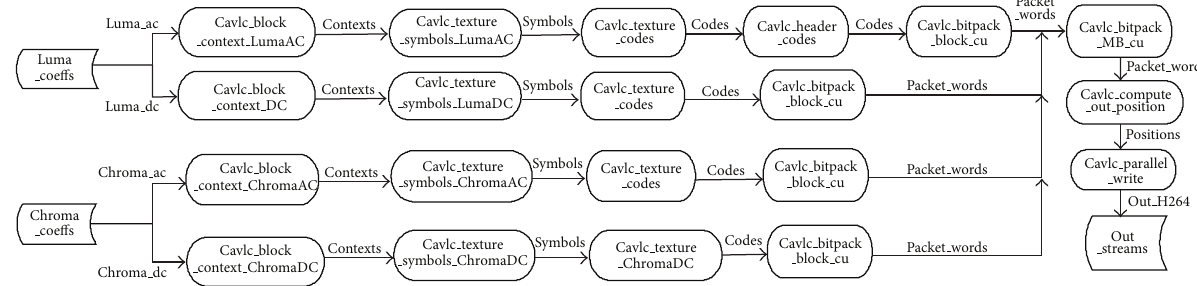
Figure 9: The component-based